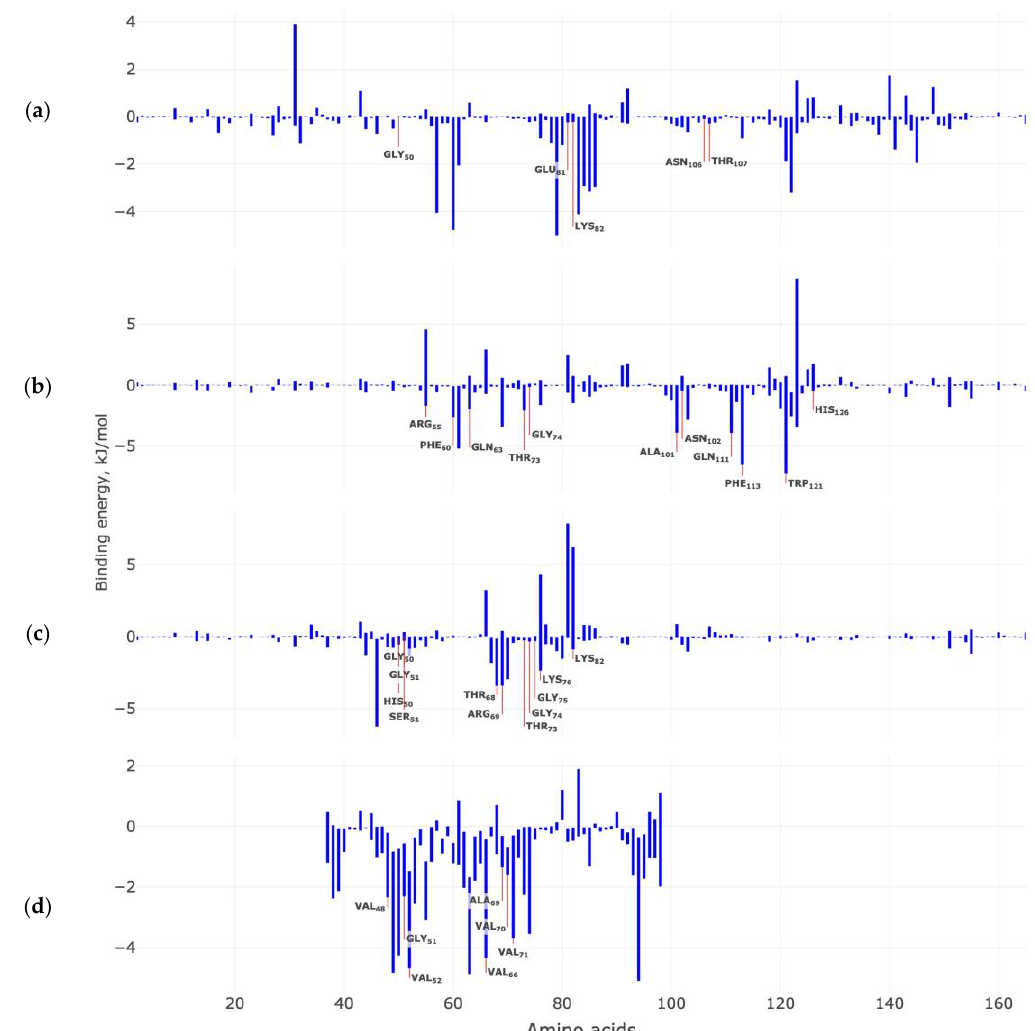
Figure 10. Contribution of target protein amino acids to the calculated binding energies (kJ/mol) with the Anle138b isomer ligand: ( a ) A α Syn–CypA; ( b ) CypA dimer; ( c ) dimer of the A α Syn–CypA complex; ( d ) A α Syn filament. In the figures, amino acids marked in yellow make a significant contribution to the stabilization of the complex according to the results of molecular docking experiments.